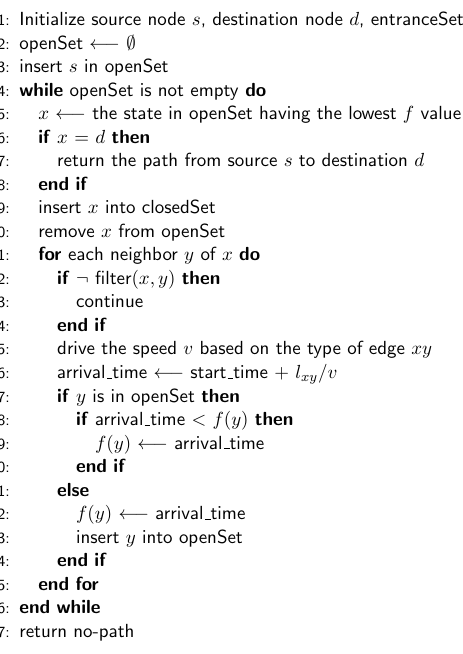
Figure 12. The modified Dijkstra algorithm for indoor-outdoor route planning.